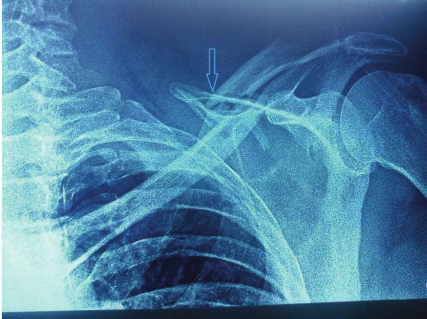
Figure 1: Clavicle radiography showing the clavicle fracture.